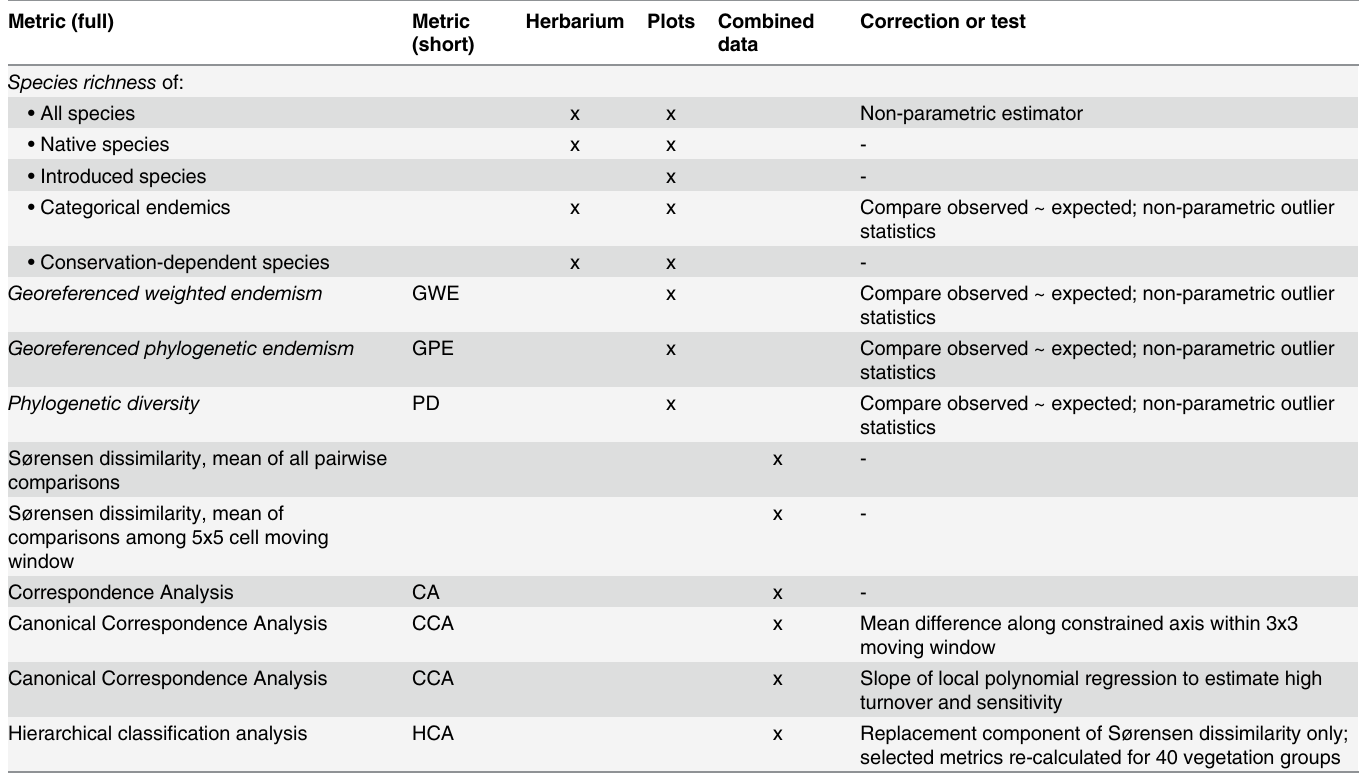
Table 1. Biodiversity metrics mapped for South Australia and associated datasets and